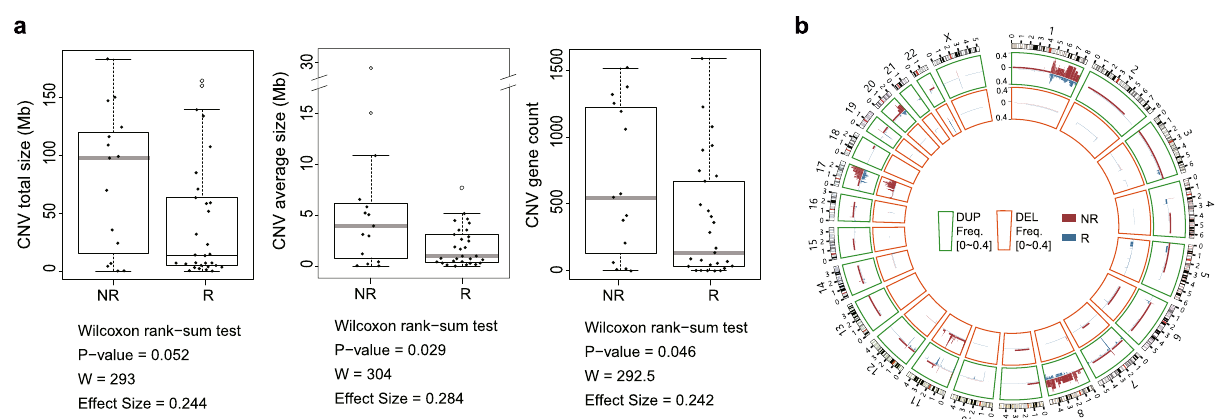
Fig. 4 Comparison of copy number variants between responders and non-responders. a Comparison of copy number variants (CNV, total and average length) and CNV gene count between responders and non-responders. P values were calculated by the Wilcox rank-sum test. b Circos plots depict CNV types and frequencies in the 30 responders and 15 non-responders. The frequency of duplications per genome base in each group is shown in histogram plots and indicated in the regions marked by green lines (max: 0.6). Also, the frequency of deletions (DEL) is indicated in the regions marked by orange lines (max: